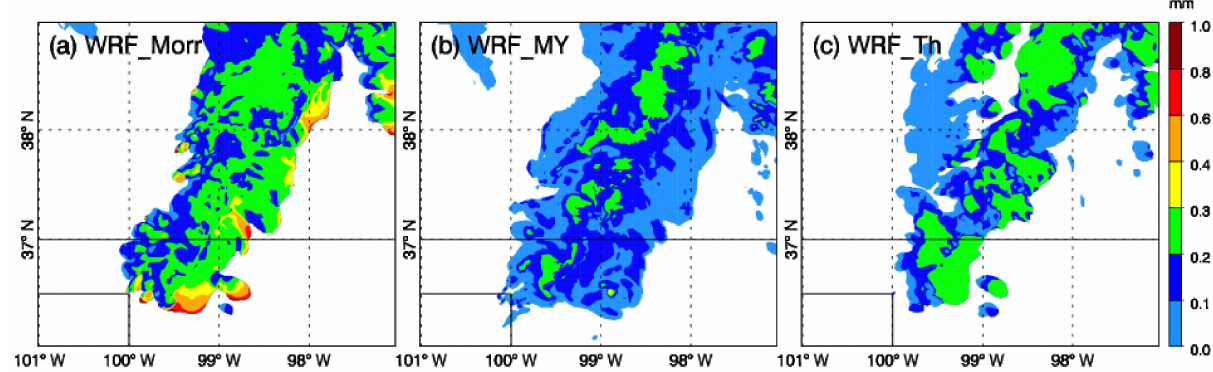
Figure 6. Mean mass diameter of rain particles at 1 km height for ( a ) WRF_Morr, ( b ) WRF_MY and ( c ) WRF_Th at 2345 UTC 29 May